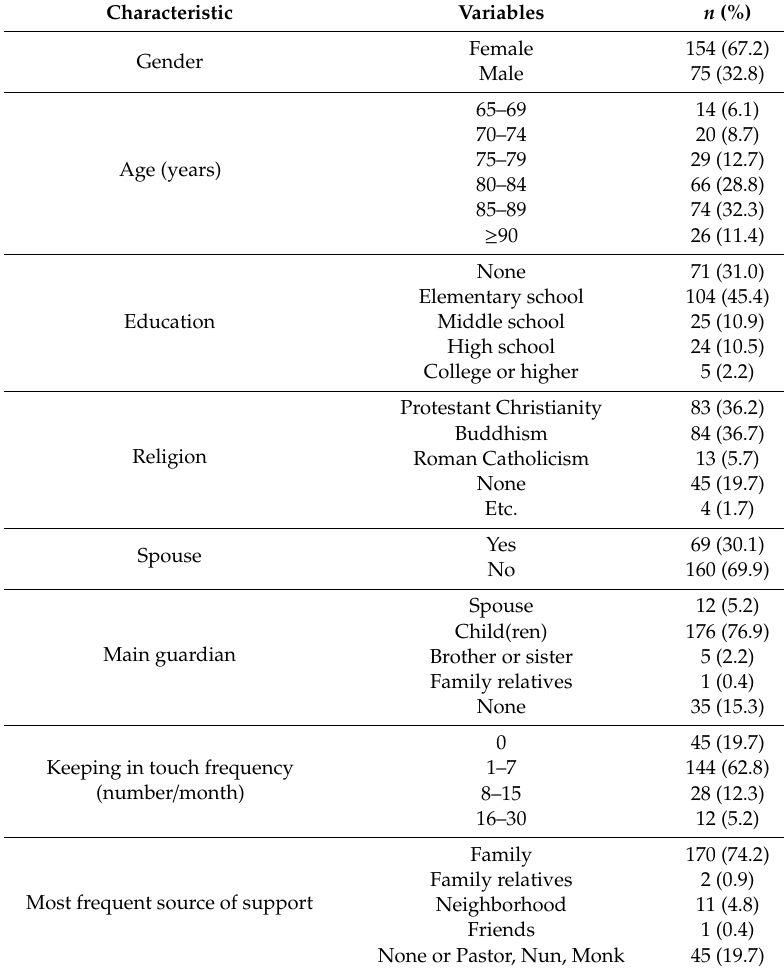
Table 1. General characteristics of study participants ( n = 229).